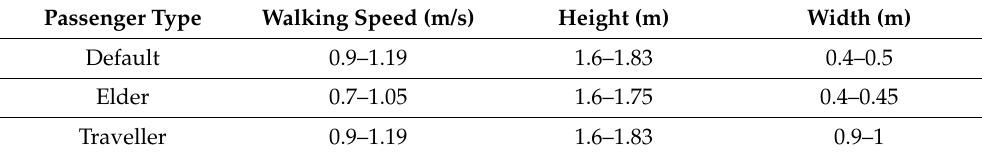
Table 1. Passenger pro fi les and their physical characteristics.